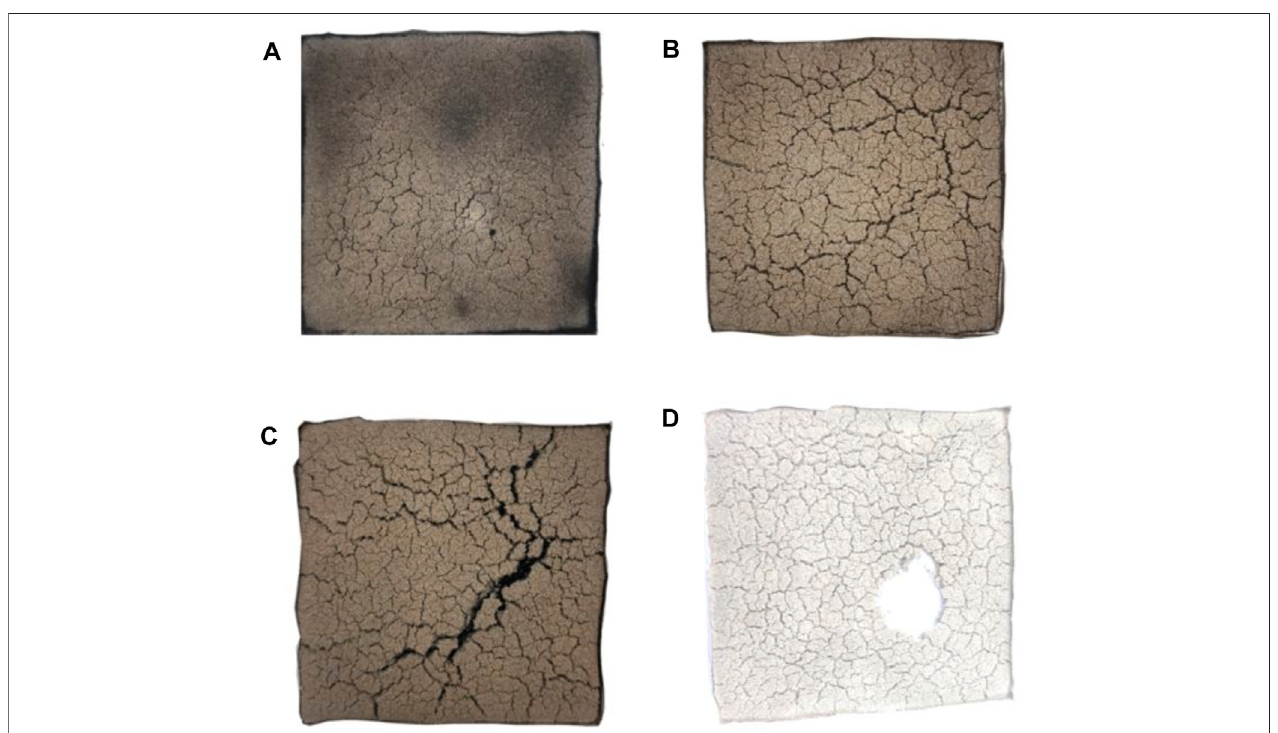
FIGURE 13 | Char residue photos of Anthracite: (A) HM15, (B) HM15, (C) HM35, and (D) HM50.